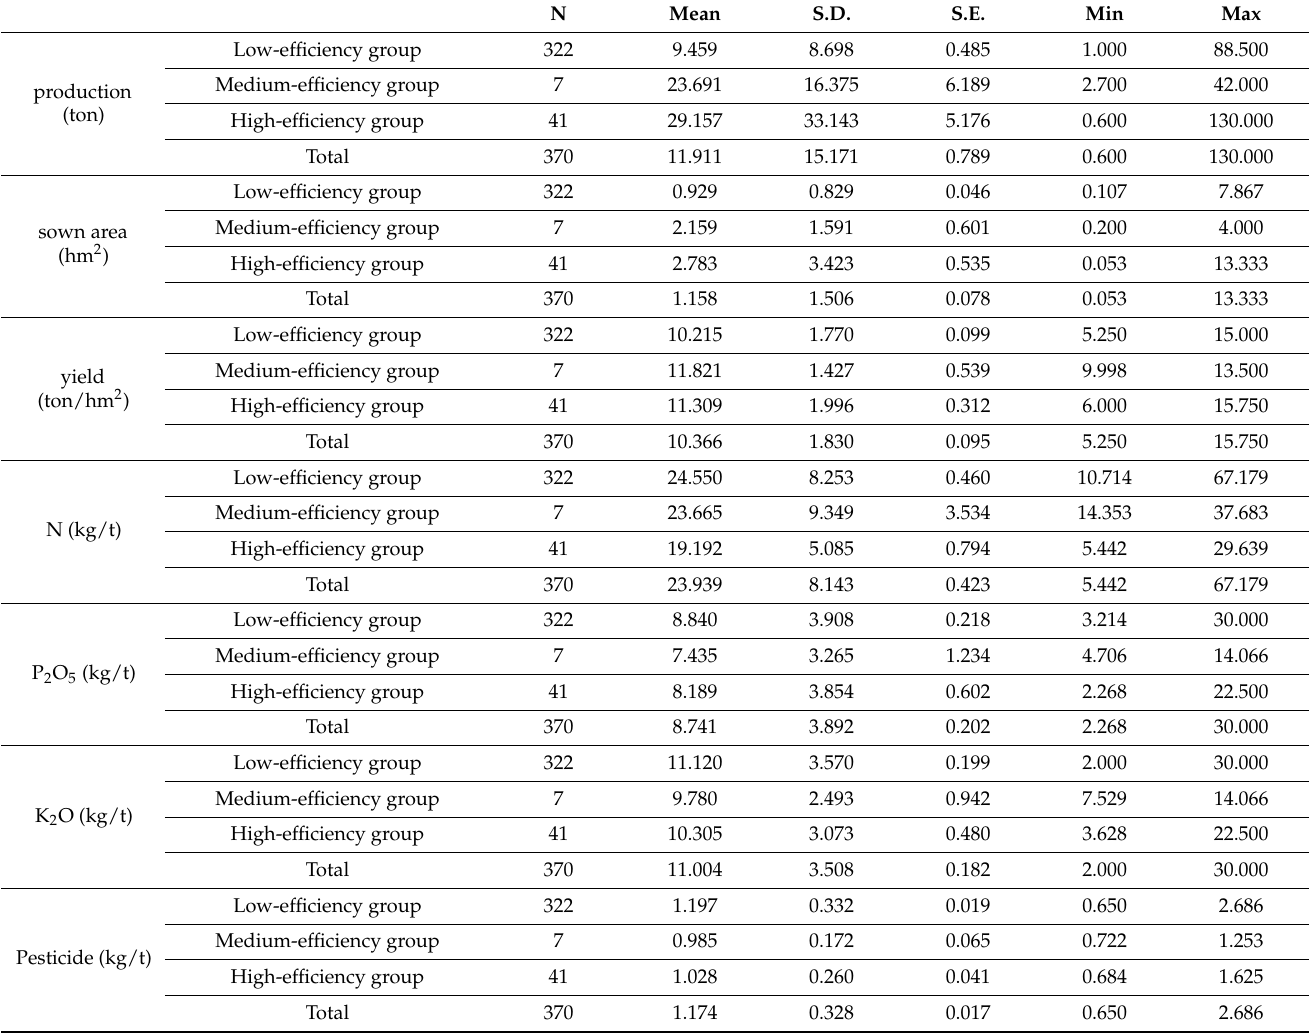
Table A2. Descriptive statistical analysis of different rice eco-efficiency